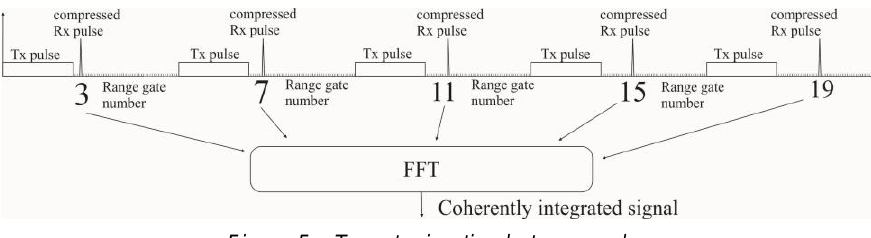
Figure 5 – Target migration between pulses Рис. 5 – Миграция цели между